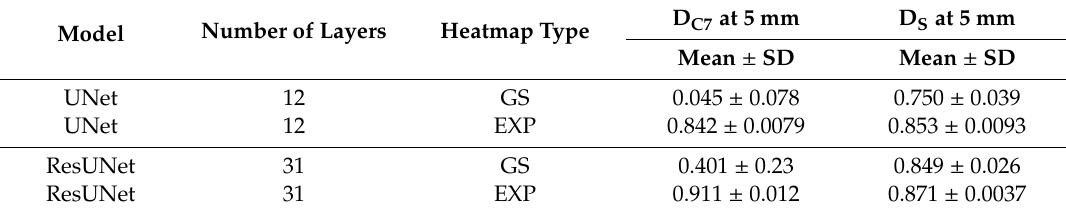
Table 4. The 5-mm detection rates of models trained using σ = 1.57. Mean ± standard deviation (SD) of the detection rates were obtained following the procedure of 10-fold